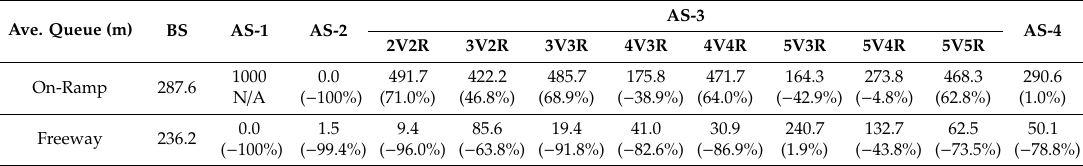
Table 6. Average queue length results of each